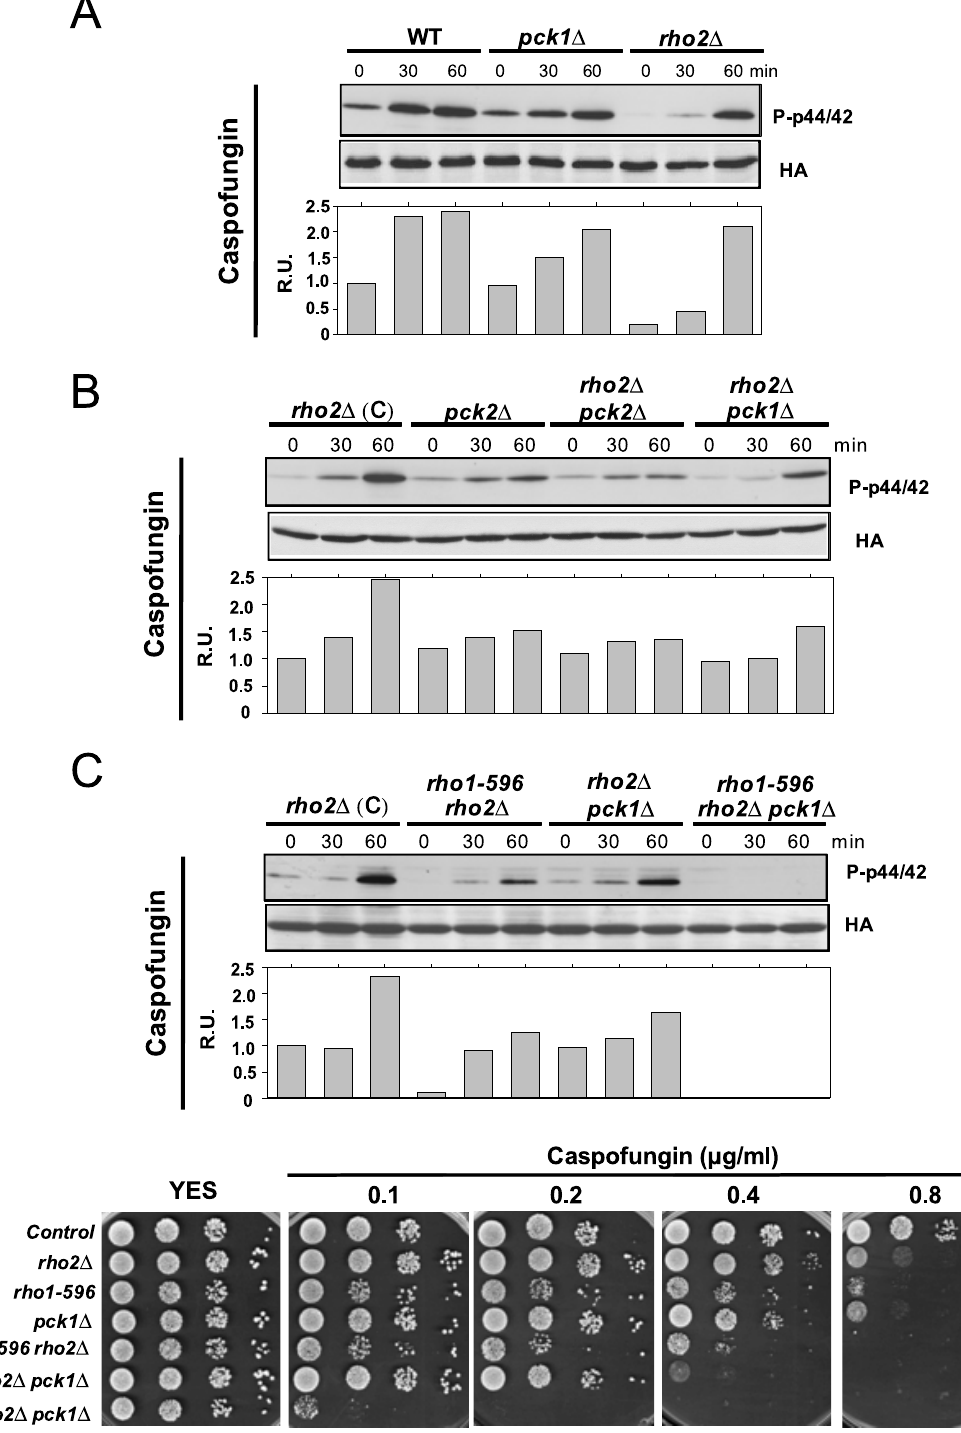
Figure 4. Pck1 participates in Pmk1 activation in response to specific cell wall stresses. (A) Strains MI200 (WT), GB35 ( pck1 D ), and MI700 ( rho2 D ); (B) MI700 ( rho2 D ), GB3 ( pck2 D ), GB29 ( rho2 D pck2 D ), and LS206 ( rho2 D pck1 D ); and (C) MI700 ( rho2 D ), LS202 ( rho1-596 rho2 D ), LS206 ( rho2 D pck1 D ), and LS208 ( rho1-596 rho2 D pck1 D ), were grown in YES medium to mid log-phase and treated with 1 m g/ml Caspofungin. At different times Pmk1-HA6H was purified and both activated and total Pmk1 were detected by immunoblotting with anti-phospho-p42/44 and anti-HA antibodies, respectively. (D) Strains described above were grown in YES medium, and 10 4 , 10 3 , 10 2 and 10 cells were spotted onto YES plates supplemented with increased concentrations of Caspofungin. The plates were incubated for 4 days at 28 u C before being photographed.